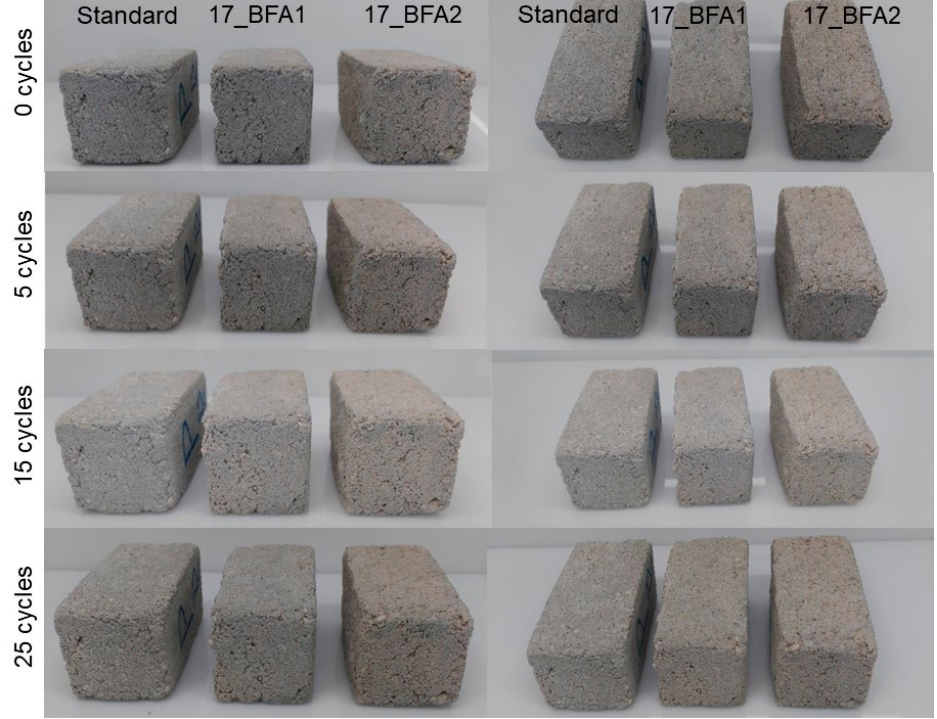
Figure 10. View of the samples after 0, 5, 15 and 25 freeze–thaw cycles.